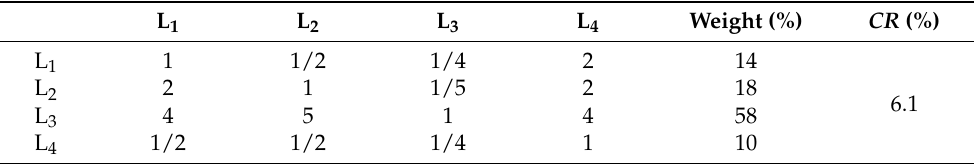
Table 11. Decision matrix of evaluation criteria. (L 1 is population; L 2 is proximity to roads; L 3 is proximity to existing fire brigade; L 4 is proximity to the